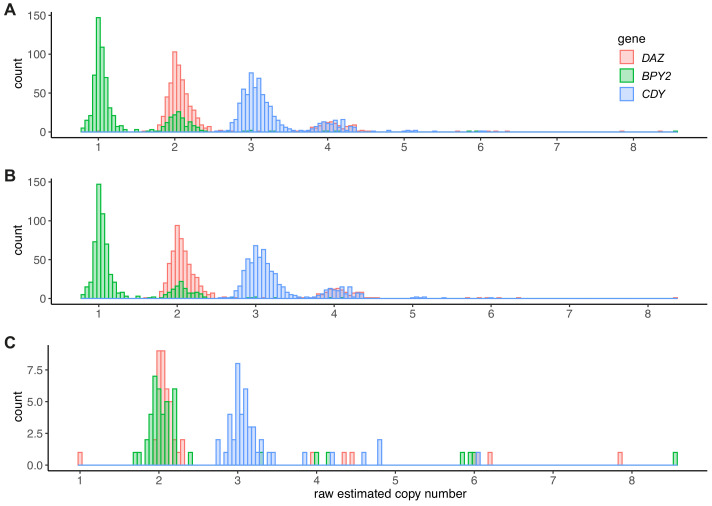
Histograms of estimated raw copy number values for DAZ, BPY2, and CDY genes by ddPCR.(A) Distribution of copy number estimates for all typed samples (n = 675); (B) samples carrying the b2/b3 or sY1191 marker deletions (n = 631); and (C) samples carrying the gr/gr deletion (n = 44). The CDY gene copy number is a sum of CDY1 and CDY2 (assumed to be two) copy numbers. Note: one patient with a gr/gr deletion appeared to carry a single copy of DAZ gene (ddPCR repeated four times). However, both the Illumina re-sequencing data and paralogous sequence variant (PSV) typing were consistent with two copies of DAZ genes being retained, and therefore in all downstream analysis, the presence of two DAZ genes was assumed. The likely reason for the discrepancy between ddPCR and re-sequencing/PSV typing is a disruption of ddPCR primer or probe binding site.